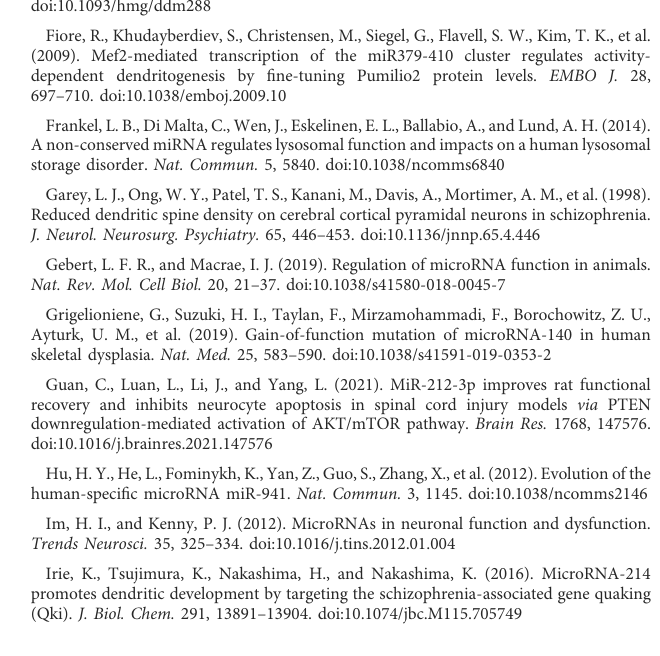
SUPPLEMENTARY FIGURE S1 miR-514a promotes neuronal differentiation of human iPSCs. iPSCs (201B7, 585A1, and 648A1) were cultured in differentiation medium and lentivirus expressing miR-514a was transduced at the induction step into neuronal differentiation. Differentiated neurons were examined by immunocytochemistry using anti-Tuj-1 and anti-MAP2 antibodies. (A – C) Representative images of iPSC-derived neurons stained with anti-Tuj-1 (green) antibody, anti-MAP2 (blue) antibody and Hoechst 33258 (magenta) at 7 DIV. Scale bars, 150 µm. (D – F) Quantitative analysis of Tuj-1 positive neurons. n =3independent experiments,atleast200neuronswereanalyzed in each experiment. (G – I) Quantitative analysis of MAP2 positive neurons. n = 3 independent experiments, at least 200 neurons were analyzed in each experiment. ***p < 0.001, **p < 0.01, *p < 0.05. Abbreviations: Tuj-1, β - Ⅲ tubulin; MAP2, microtubule-associated protein 2; pS6, phospho-S6 ribosomal protein. SUPPLEMENTARY FIGURE S2 miR-514a mutations found in cross-species sequence comparison attenuate mature-miR-514a expression. (A) Mutation pro fi le of precursor- miR-514a (the nucleotide positions in the mutations are indicated with arrows). Mutant-1 (G > A) and -5 [C > U(T)] were located in the stem region of pre-miRNA sequence, mutant-2 [U(T) > C] and -4 [U(T) > C] were harbored within the nucleotides of mature miRNA and mutant-3 (A > G) was located in the loop region of pre-miRNA. These variants are single-nucleotide substitutions that are conserved in humans and chimpanzees but not in other primates, dogs, or horses. (B) The expression levels of mature-miR-514a in mutants detected by qRT-PCR. ****p < 0.0001. Abbreviations: n.s., not signi fi